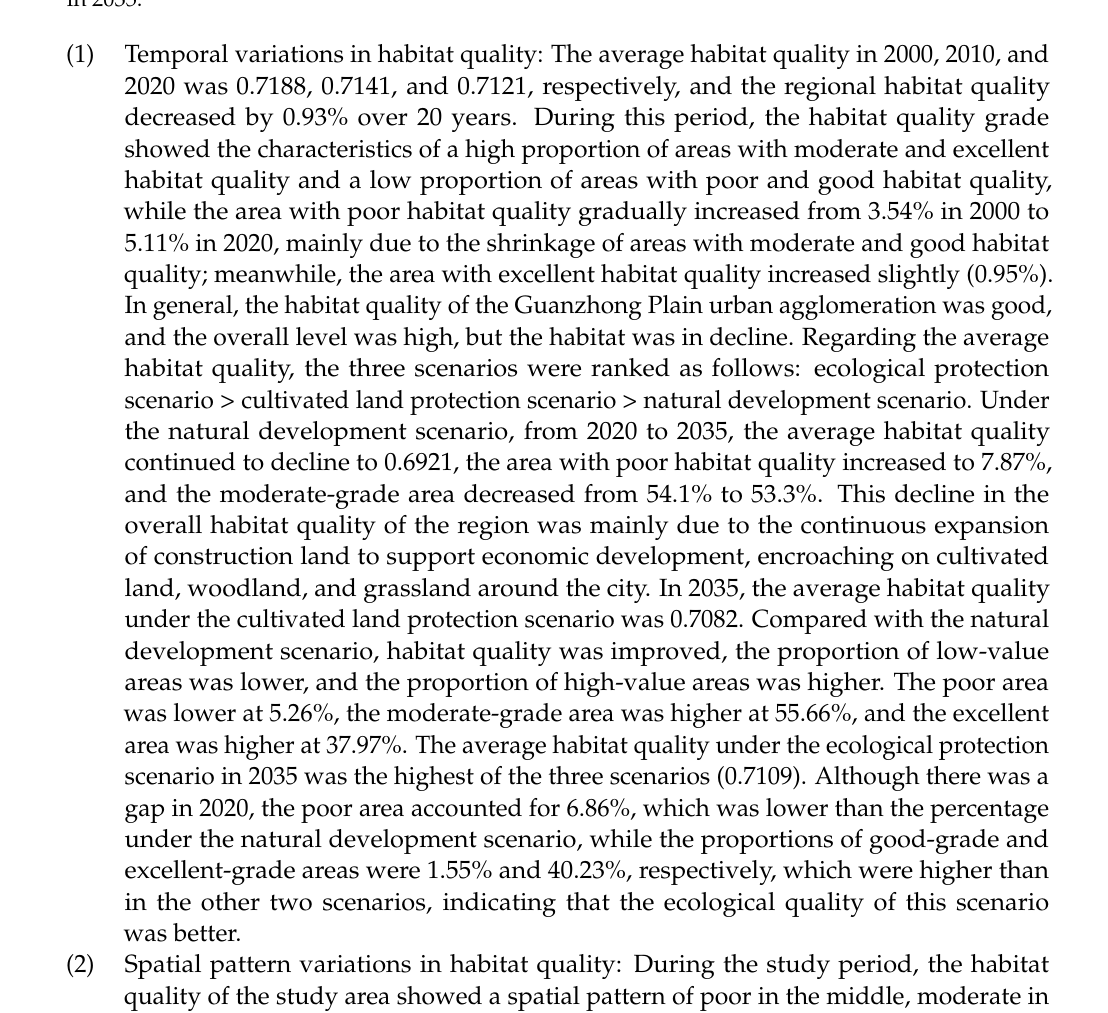
Figure 7. The ratio of habitat quality grade area in 2000, 2010, and 2020 and under each scenario in 2035.